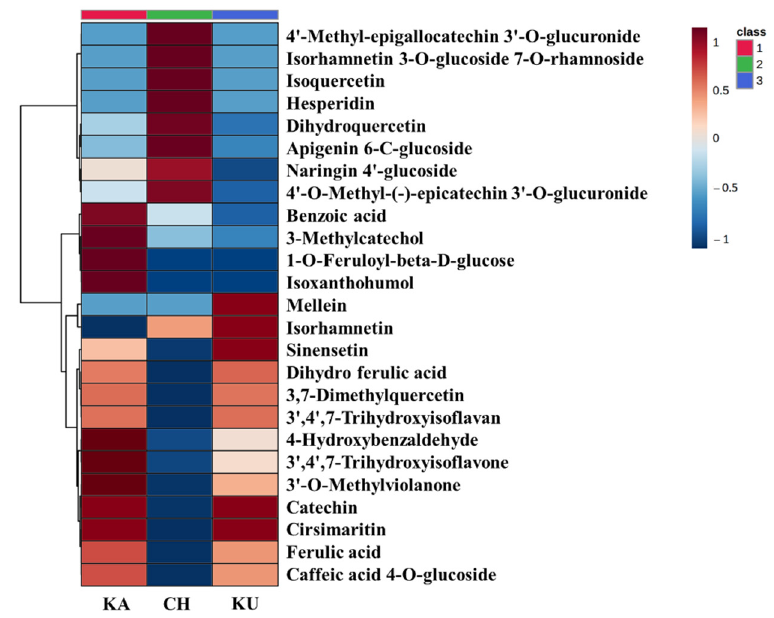
Figure 2. Heatmap showing relative concentrations of top 25 phenolic metabolites in Kattuyanam (KA), Chennangi (CH), and Karungkuruvai (KU).